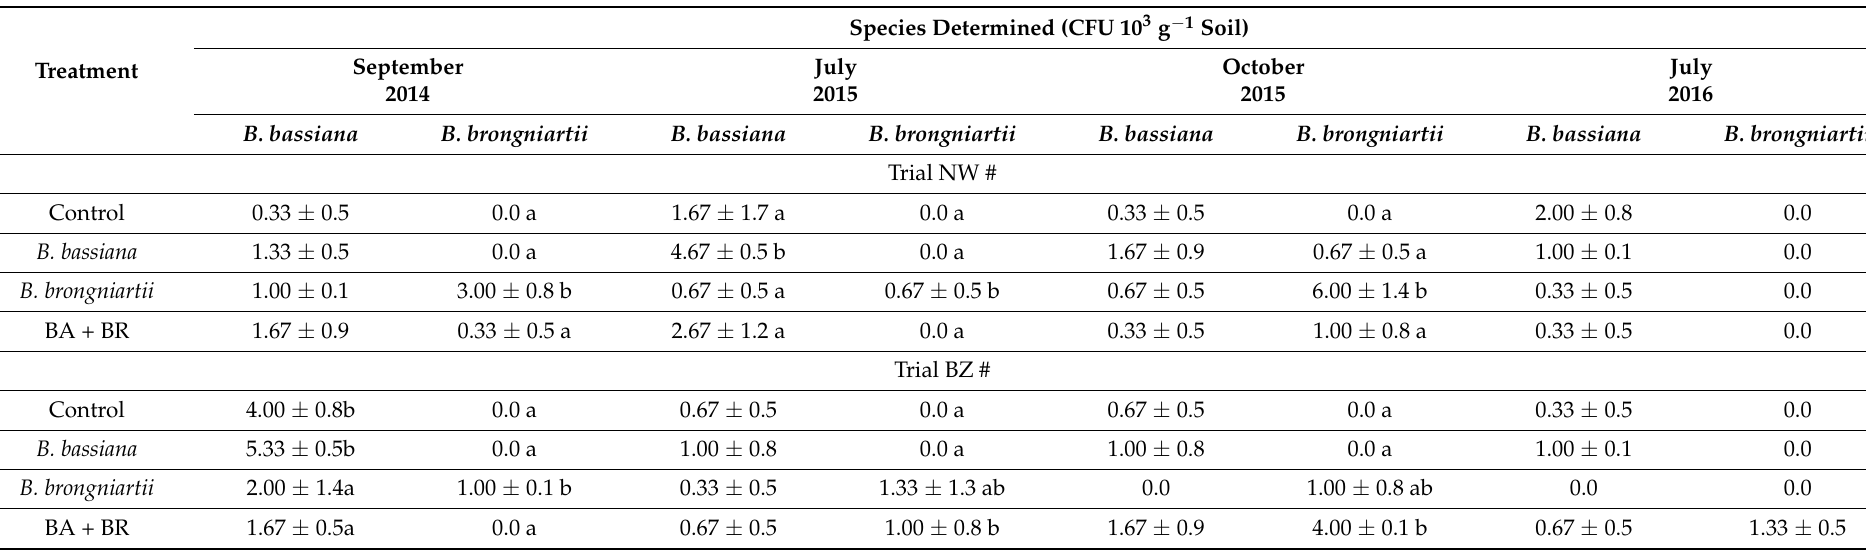
Table 2. Number of colony-forming units (CFU) (10 3 g − 1 soil) of two entomopathogenic fungi populations ( B. bassiana and B. brongniartii ) determined in soil by microbiological selective media method as affected by the application of the bio-inoculum of the two strains alone or co-inoculated (BA + BR). Means ± SD